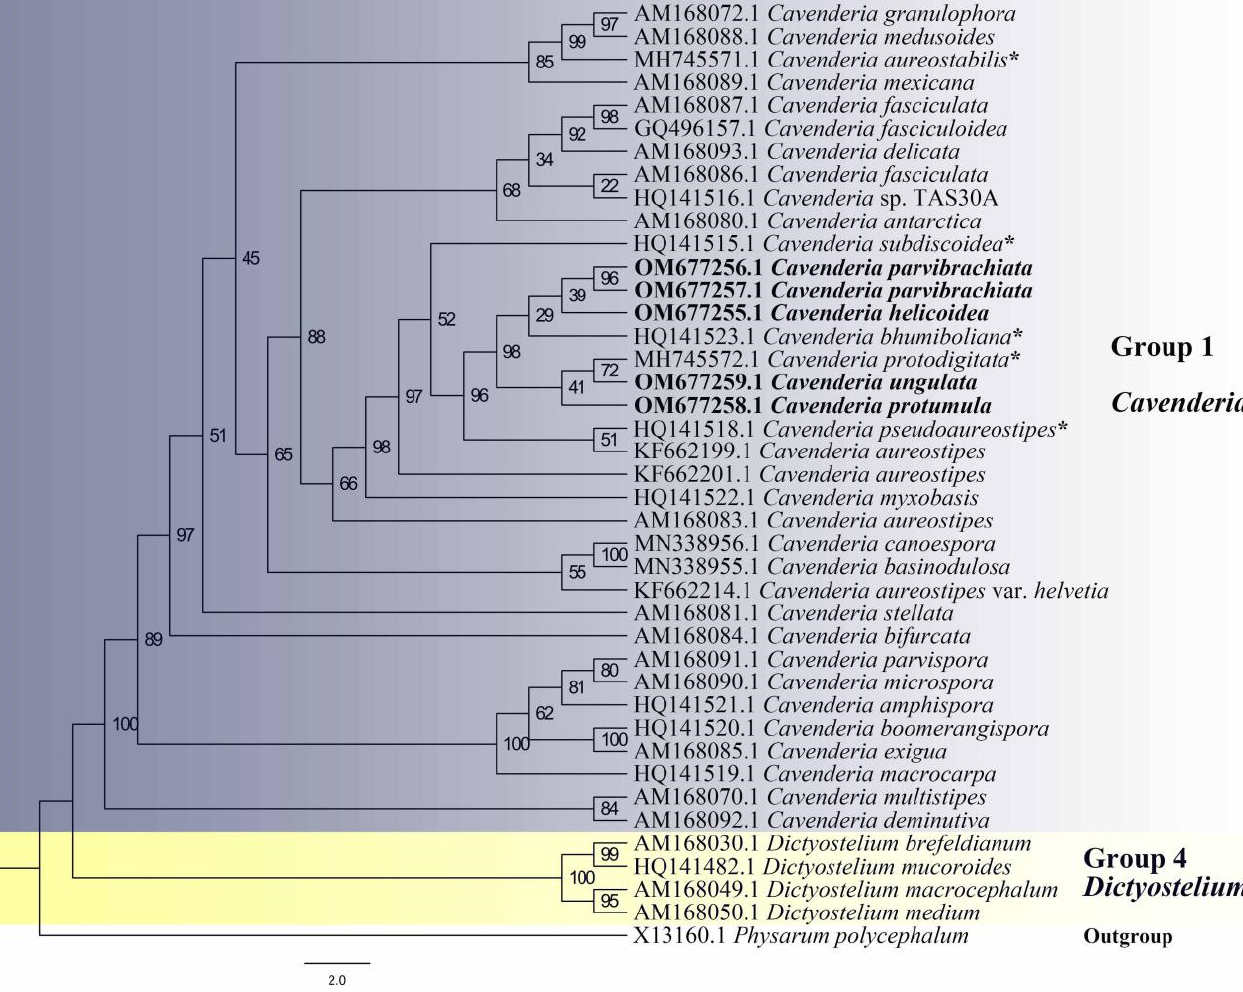
Figure 9. Phylogeny of four new species obtained in this study along with other species of Cavenderia based on SSU rRNA. Names in bold are the sequences obtained in this study, names with asterisks are the other five new species that were discovered and reported in this locality previously. The accession numbers are listed to the left of the species names. Complete strain information and GenBank accession numbers for all taxa in this tree can be observed in Table 1. The tree was derived using IQ-TREE with ultrafast bootstrap approximation (UFBoot) by TVMe+R5 model. The phylogeny is rooted according to Sheikh et al. [3].